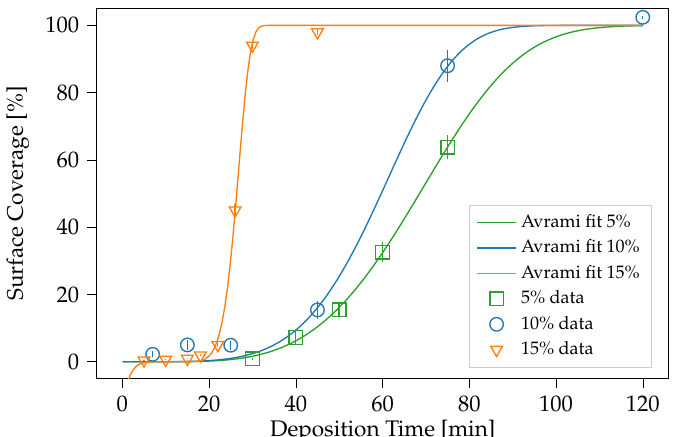
Figure 4. Graph of the Avrami fits for the three sets of data: 5% in green, 10% in blue, and 15% in orange.